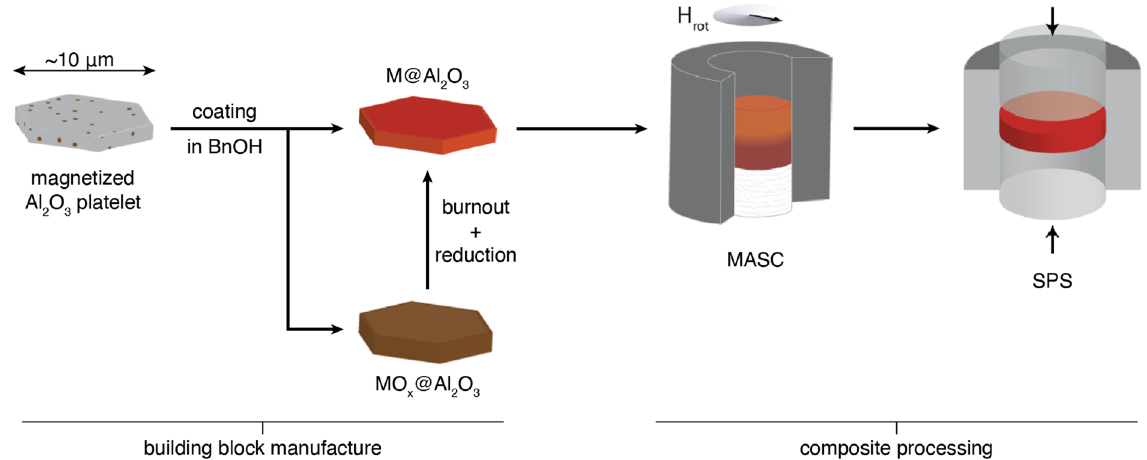
Figure 1. Processing route used for the fabrication of metal–ceramic nacre-like composites through the assembly of coated platelets followed by densification at high temperature. BnOH: benzyl alcohol. M: metal. MO x : metal oxide. H rot : rotating magnetic field. MASC: magnetically-assisted slip casting. SPS: Spark Plasma